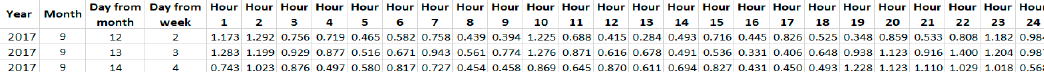
Figure 5. A sequence from the energy consumption file (SME with the smart meter installed).